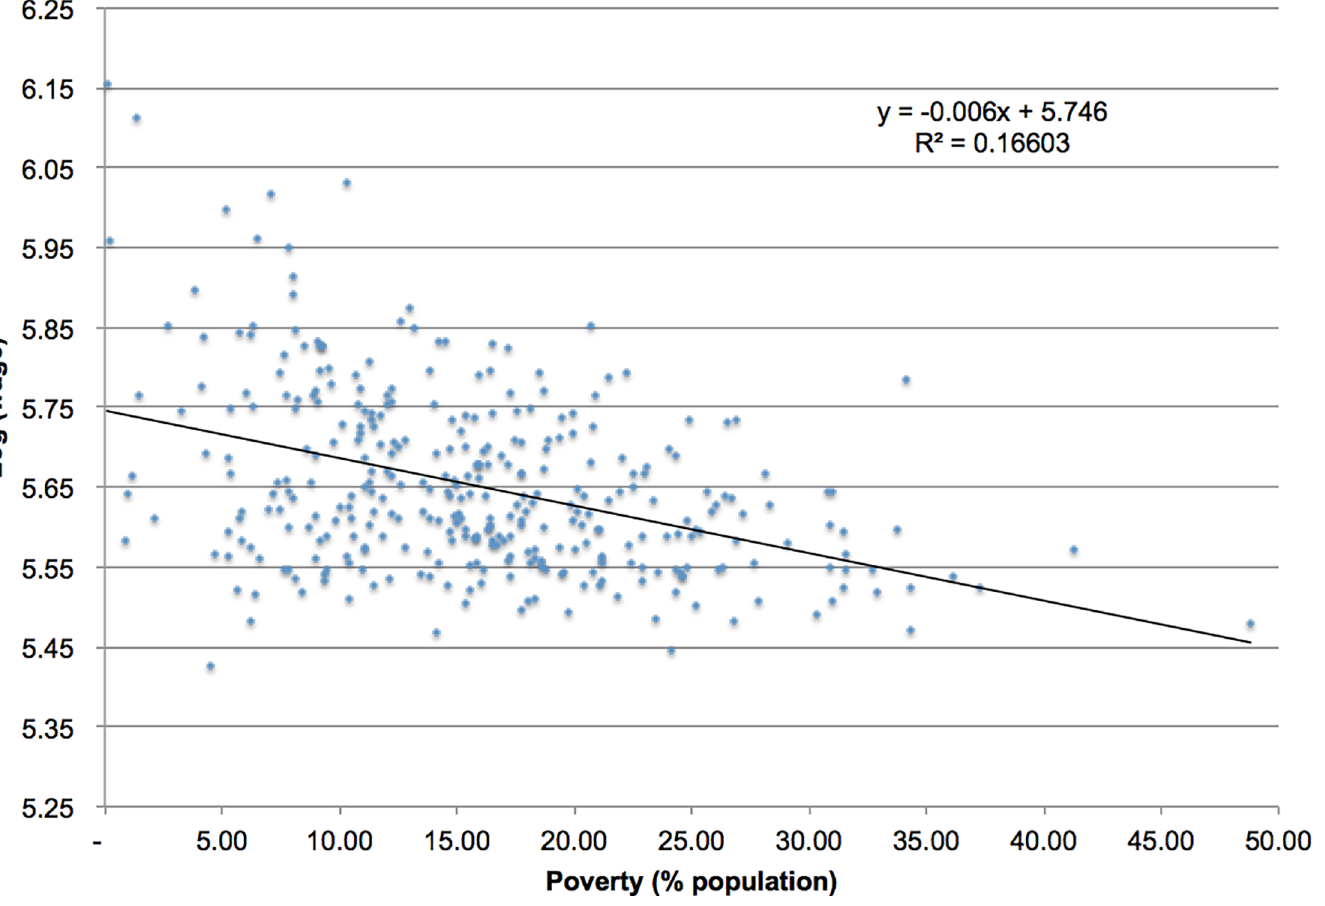
Fig 3. Poverty rates and wages by